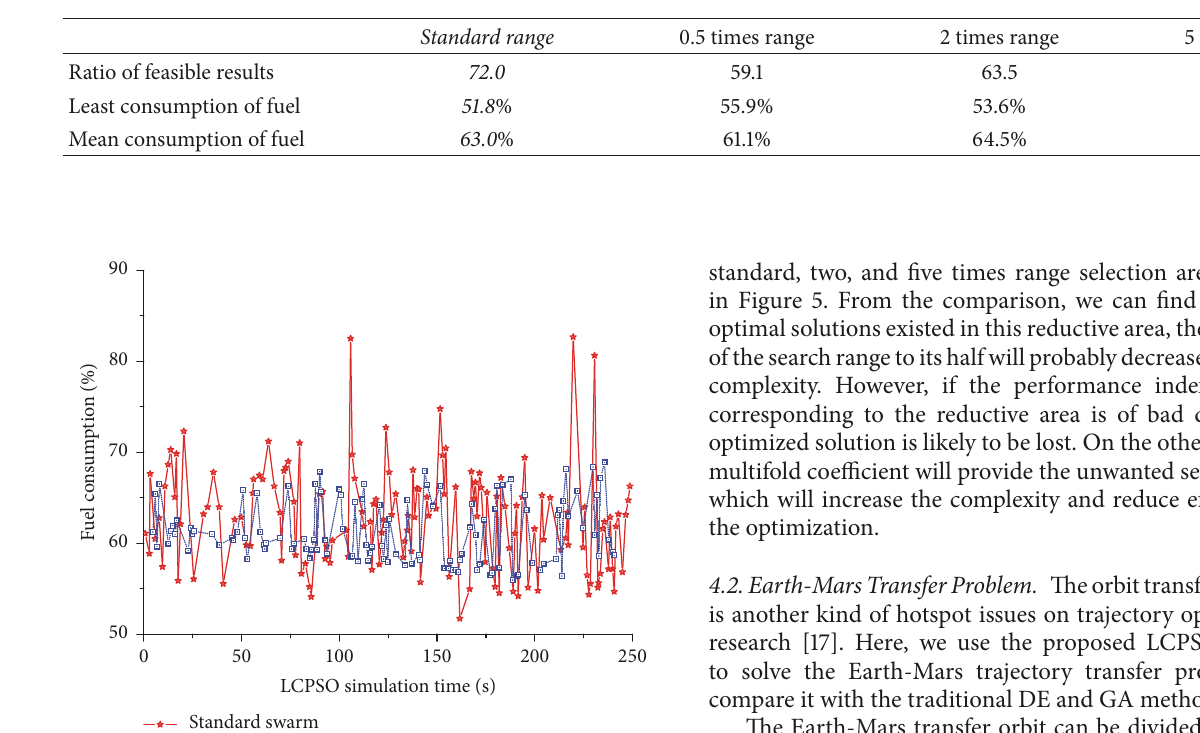
Table 2: Coefficient range selection results.